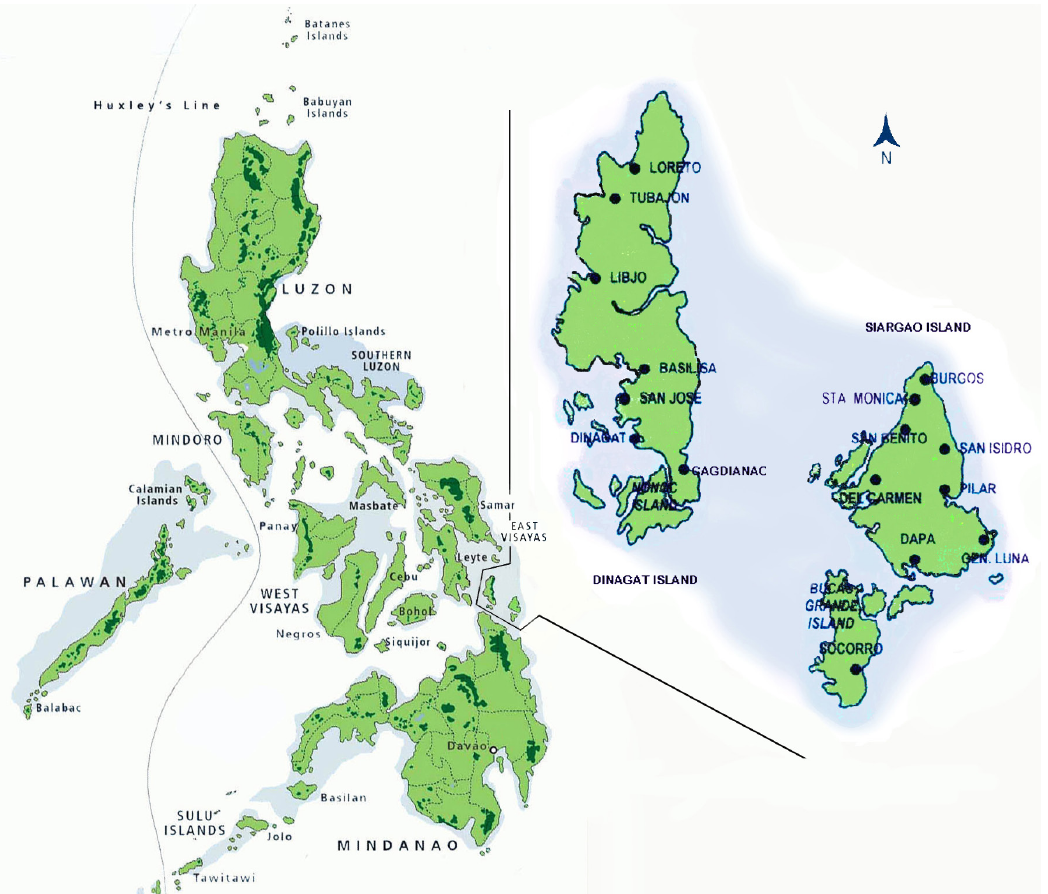
Figure 1. The Philippines showing principal ‘faunal regions’ and location of the ‘Dinagat - Siargao cluster’ of islands, which constitute the most distinct sub-centre of species endemism in the ‘Greater Mindanao Faunal